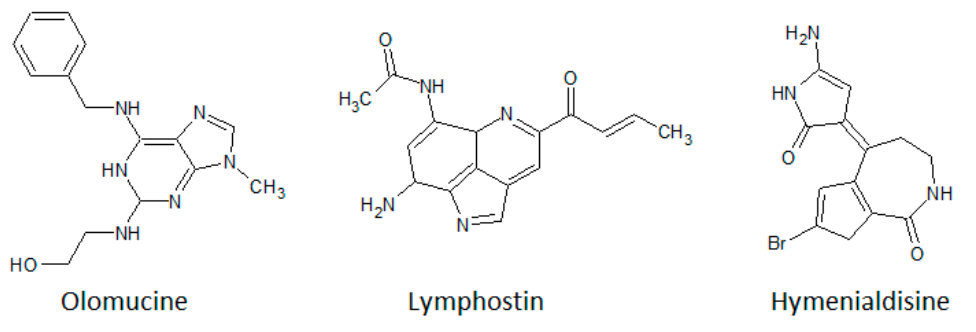
Figure 11. Chemical structures of olomoucine, lymphostin, and hymenialdisine.